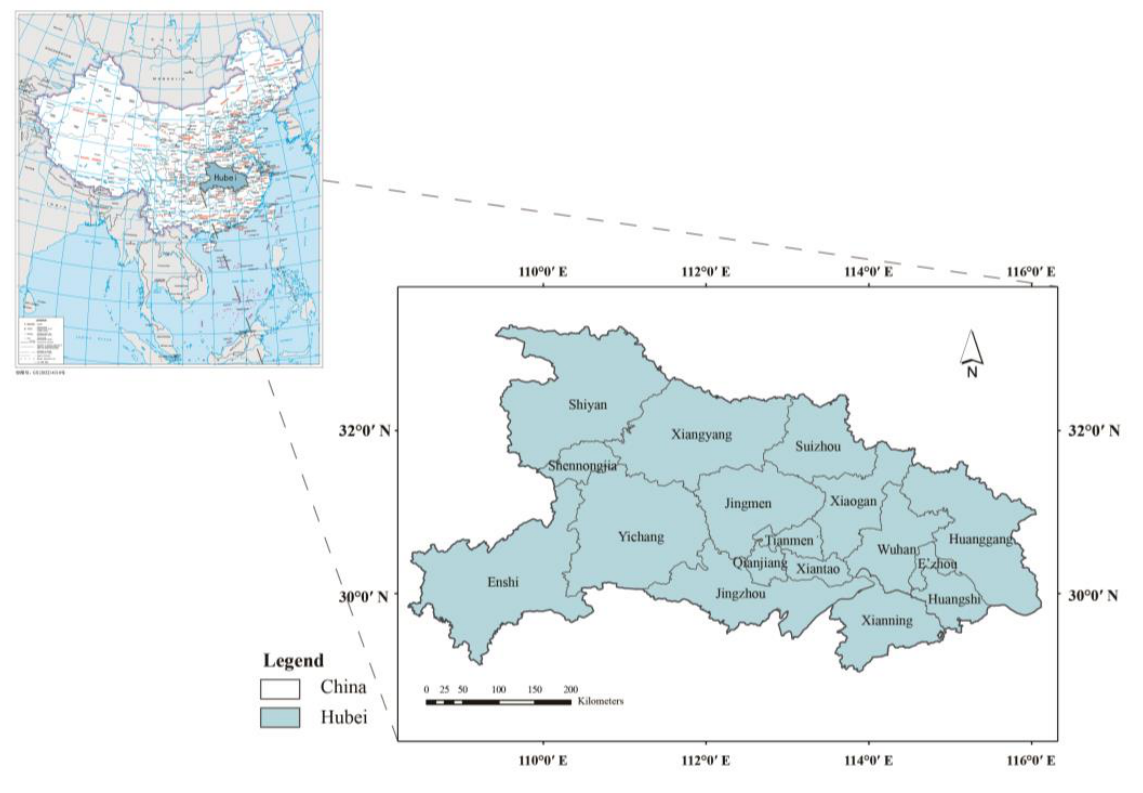
Figure 2. The location of the study area.